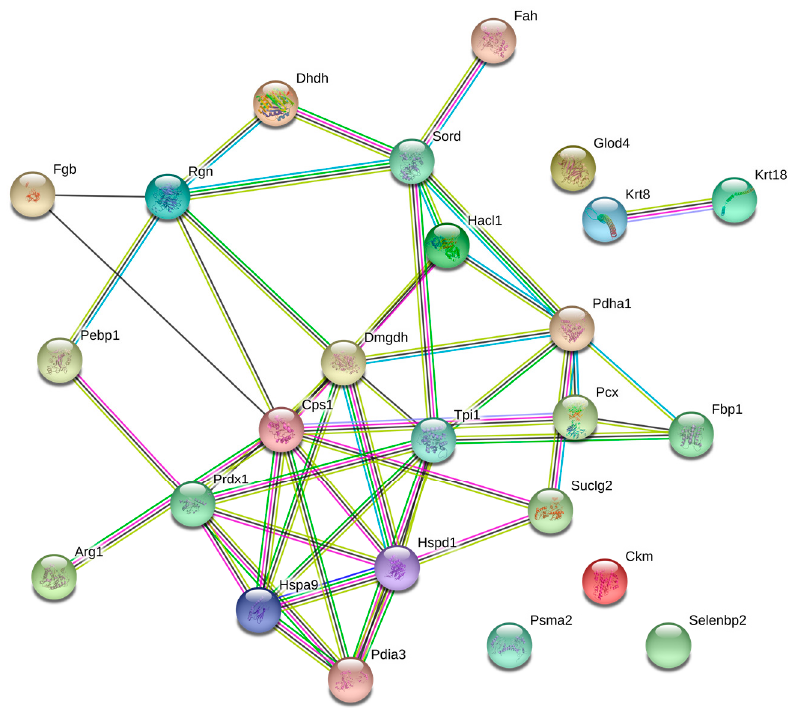
Figure 2. Network of differentially expressed proteins. The nodes stand for differentially expressed genes, and the lines stand for the interactions between two proteins.